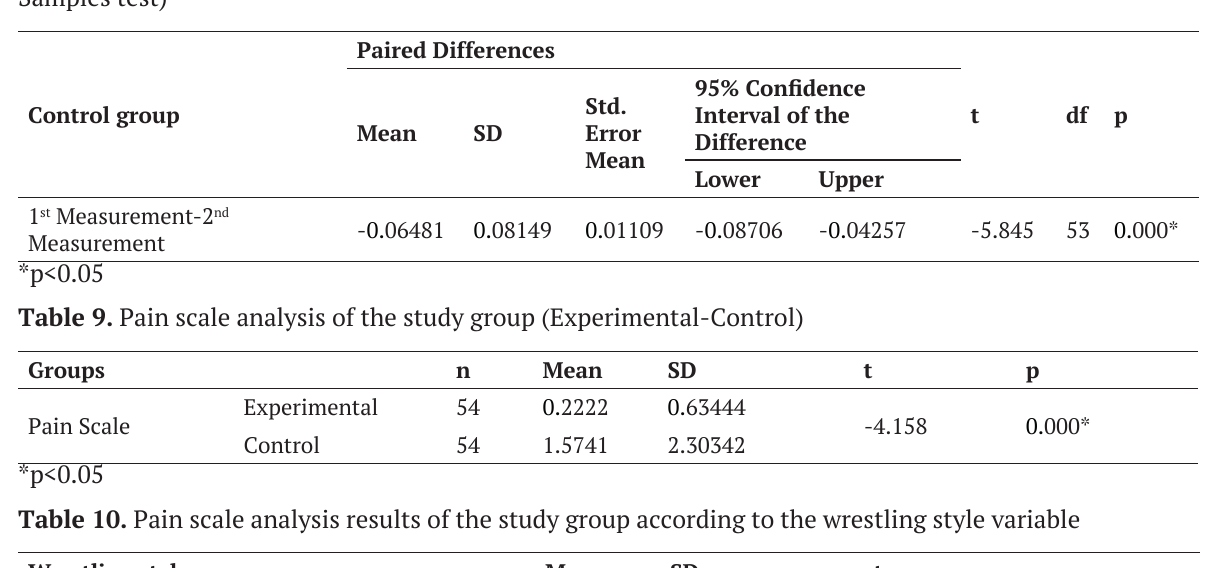
Table 8. The analysis results between the 1st and 2nd measurement values of the control group (Paired Samples test)